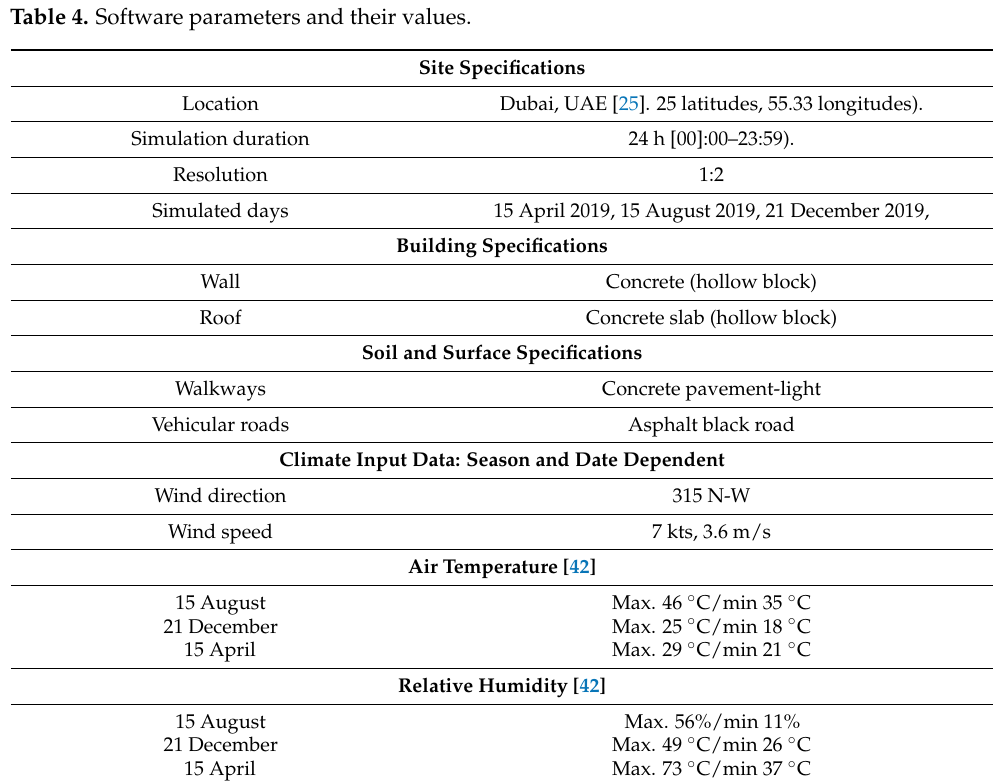
Table 4. Software parameters and their